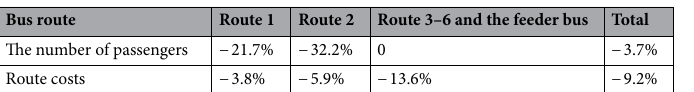
Table 5. The variation of the number of passengers and route costs.